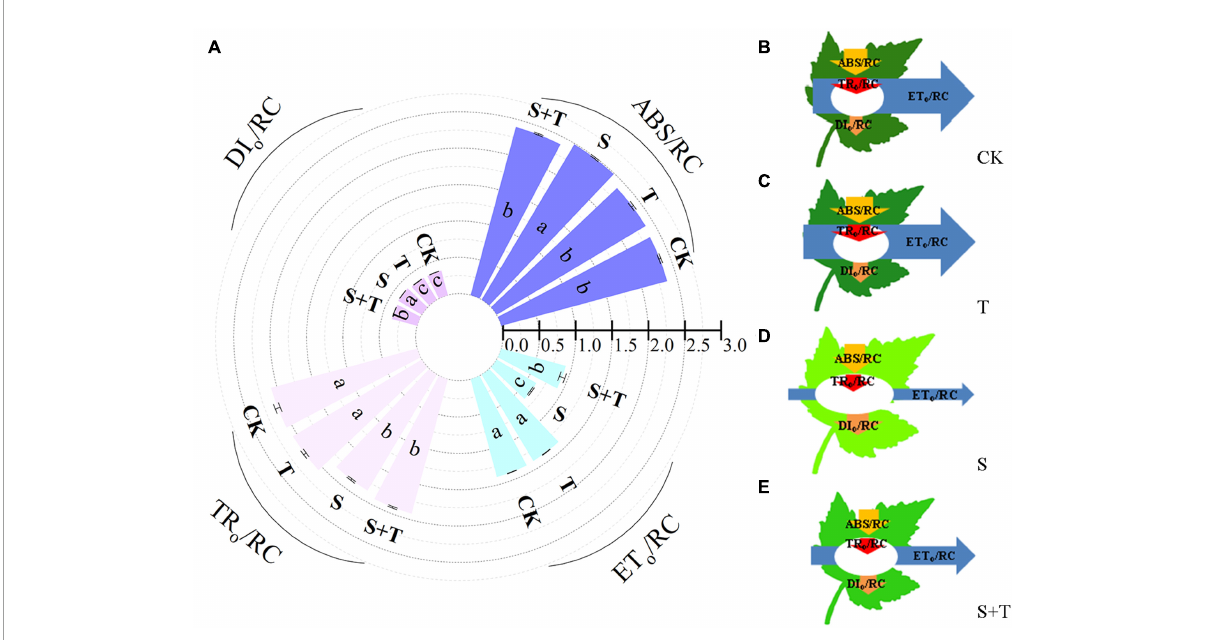
FIGURE7 Effects of Tre treatment on phenomenological fluxes (per active reaction center, RC) of tomato seedlings exposed to salt stress for 5 d. (A) Electron absorption, capture, transport and dissipation flux per RC. The results showed the mean ± SE of three replicates, and the different letters denote the significant difference among treatments ( P < 0.05), according to Duncan’s multiple tests. (B–E) Energy pipeline leaf model of phenomenological fluxes (per active reaction center, RC) in CK, T, S, and S+T, respectively. Changes in each energy flux were indicated by resizing the corresponding arrows. CK, control; T, 10 mM Tre; S, 150 mM NaCl; S+T, 150 mM NaCl + 10 mM